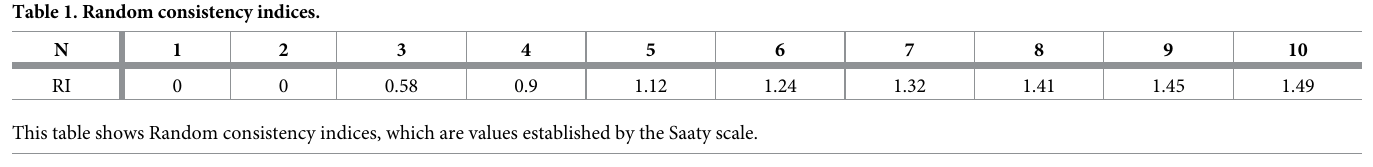
The next step of the process is to check the consistency of the data, where it is verified that the decision makers were consistent in their opinions. The next step is to calculate the main number of Eigen from the sum of the product of each element of the vector of Eigen by the total of the respective column of the original comparative matrix. Followed by the calculation of the Consistency Index (CI) , which is based on the main number of 5n . The CI is obtained, according to [34].